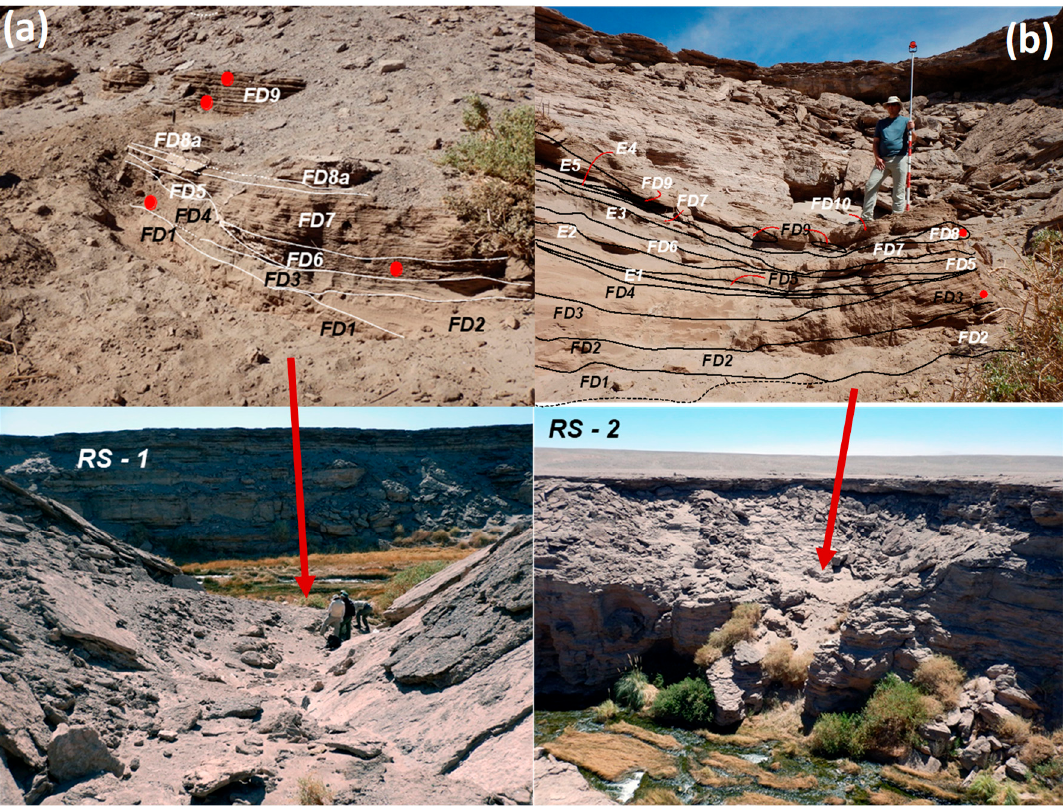
Figure 6. The 9 slackwater deposits (FD) characterized and sampled within the mouth of a tributary at RS1 ( a ); the 10 slackwater deposits characterized and sampled within a bedrock alcove at RS2 ( b ). The letter “E” refers to eolian deposits.